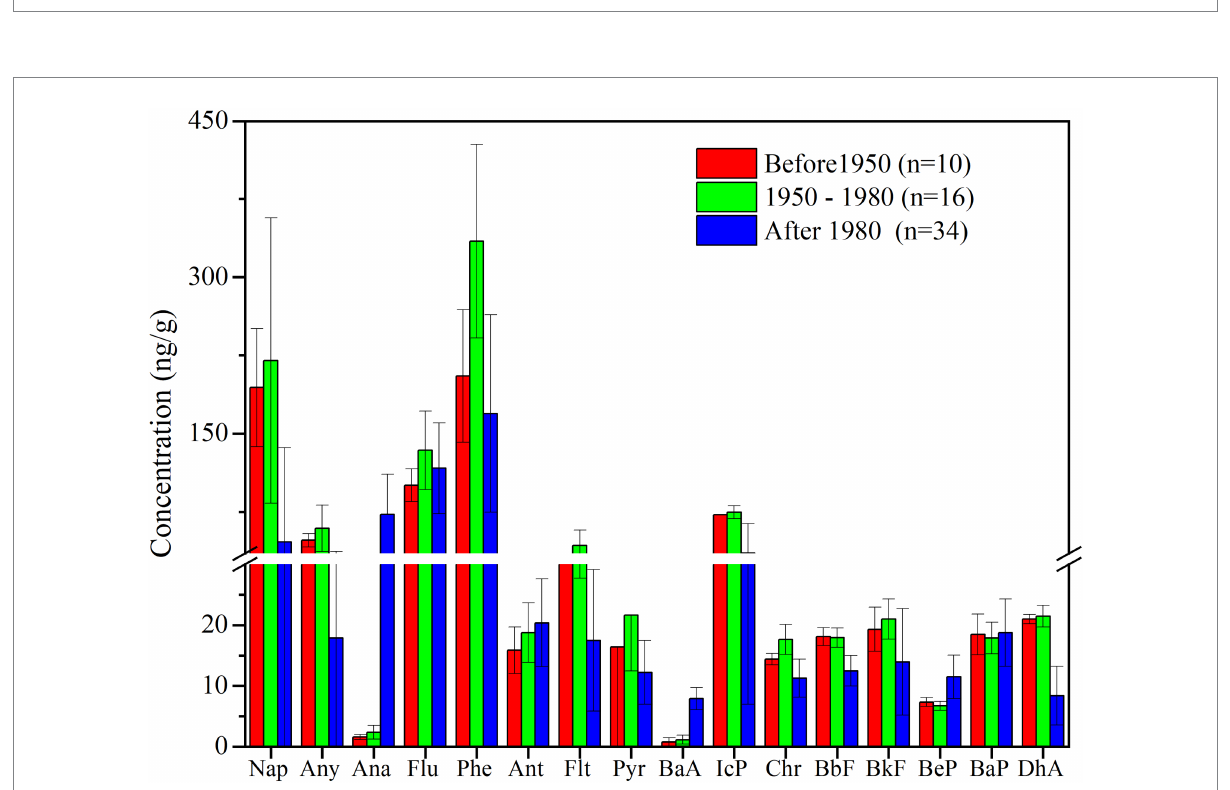
FIGURE 5 Profiles of PAHs in sediments from the JDY peat core, grouped according to the three periods. Nap, Naphthalene; Any, Acenaphthylene; Ana, Acenaphthene; Flu, Fluorene; Phe, Phenanthrene; Ant, Anthracene; Flt, Fluoranthene; Pyr, Pyrene; Chr, Chrysene; BaA, Benzo(a) anthracene; BbF, Benzo(b)fluoranthene; BkF, Benzo(k)fluoranthene; BeP, Benzo(e)pyrene; BaP, Benzo(a)pyrene; DhA, Dibenz[a,h] anthracene; and IcP, Ideno(1,2,3- cd) pyrene.